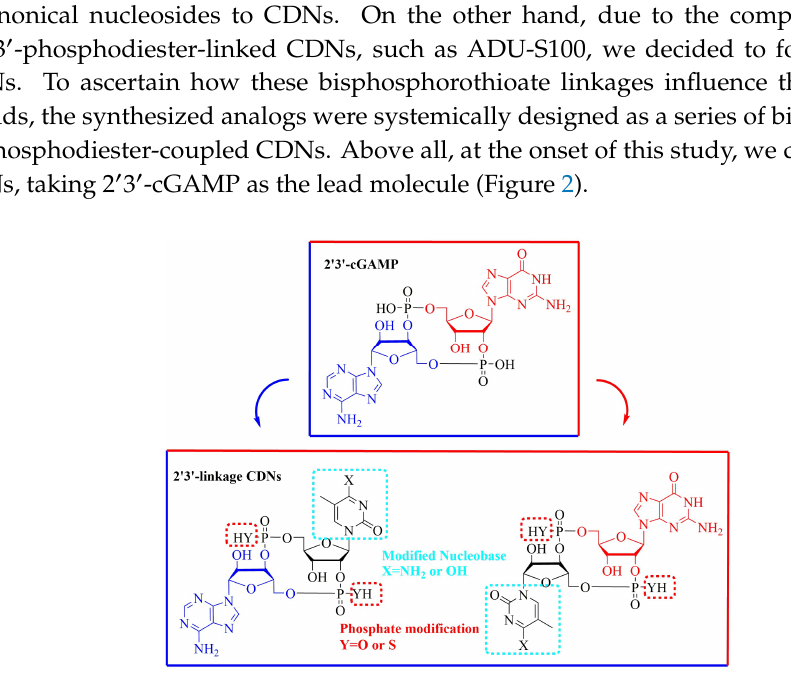
Figure 2. General structure of the cGAMP analogs in the present study.